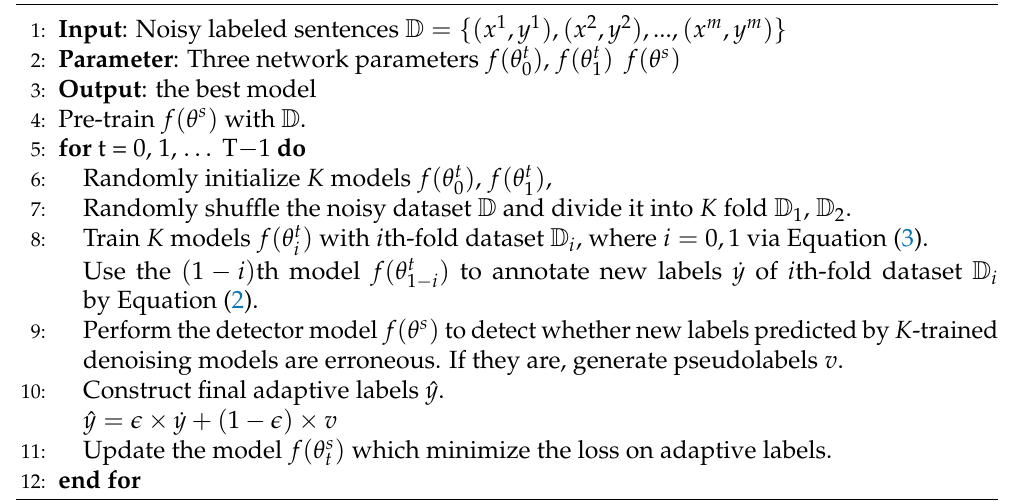
Algorithm 1 Self-Adaptive Label cOrrection